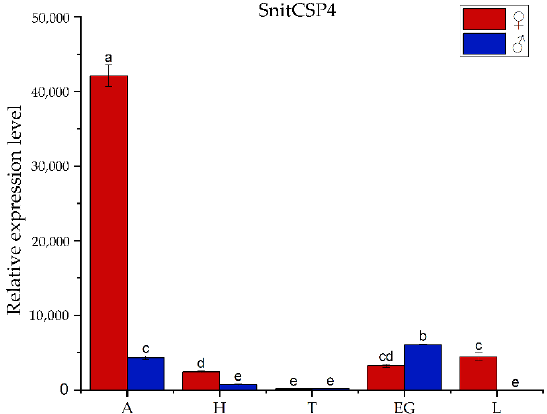
Figure 3. Transcript levels of tissue-specific CSP gene in different tissues of S. nitobei . A, antennae; H, head (without antennae); T, thorax; EG, external genitalia; L, leg. Red indicates expression in females and blue indicates expression in males. The reference gene, β -tubulin was used for normal- izing CSP genes expression and to correct for sample-to-sample variation. Transcript levels were normalized to those of FT. The standard error is represented by the error bar, and the different lower cases above each bar indicate significant differences ( p <